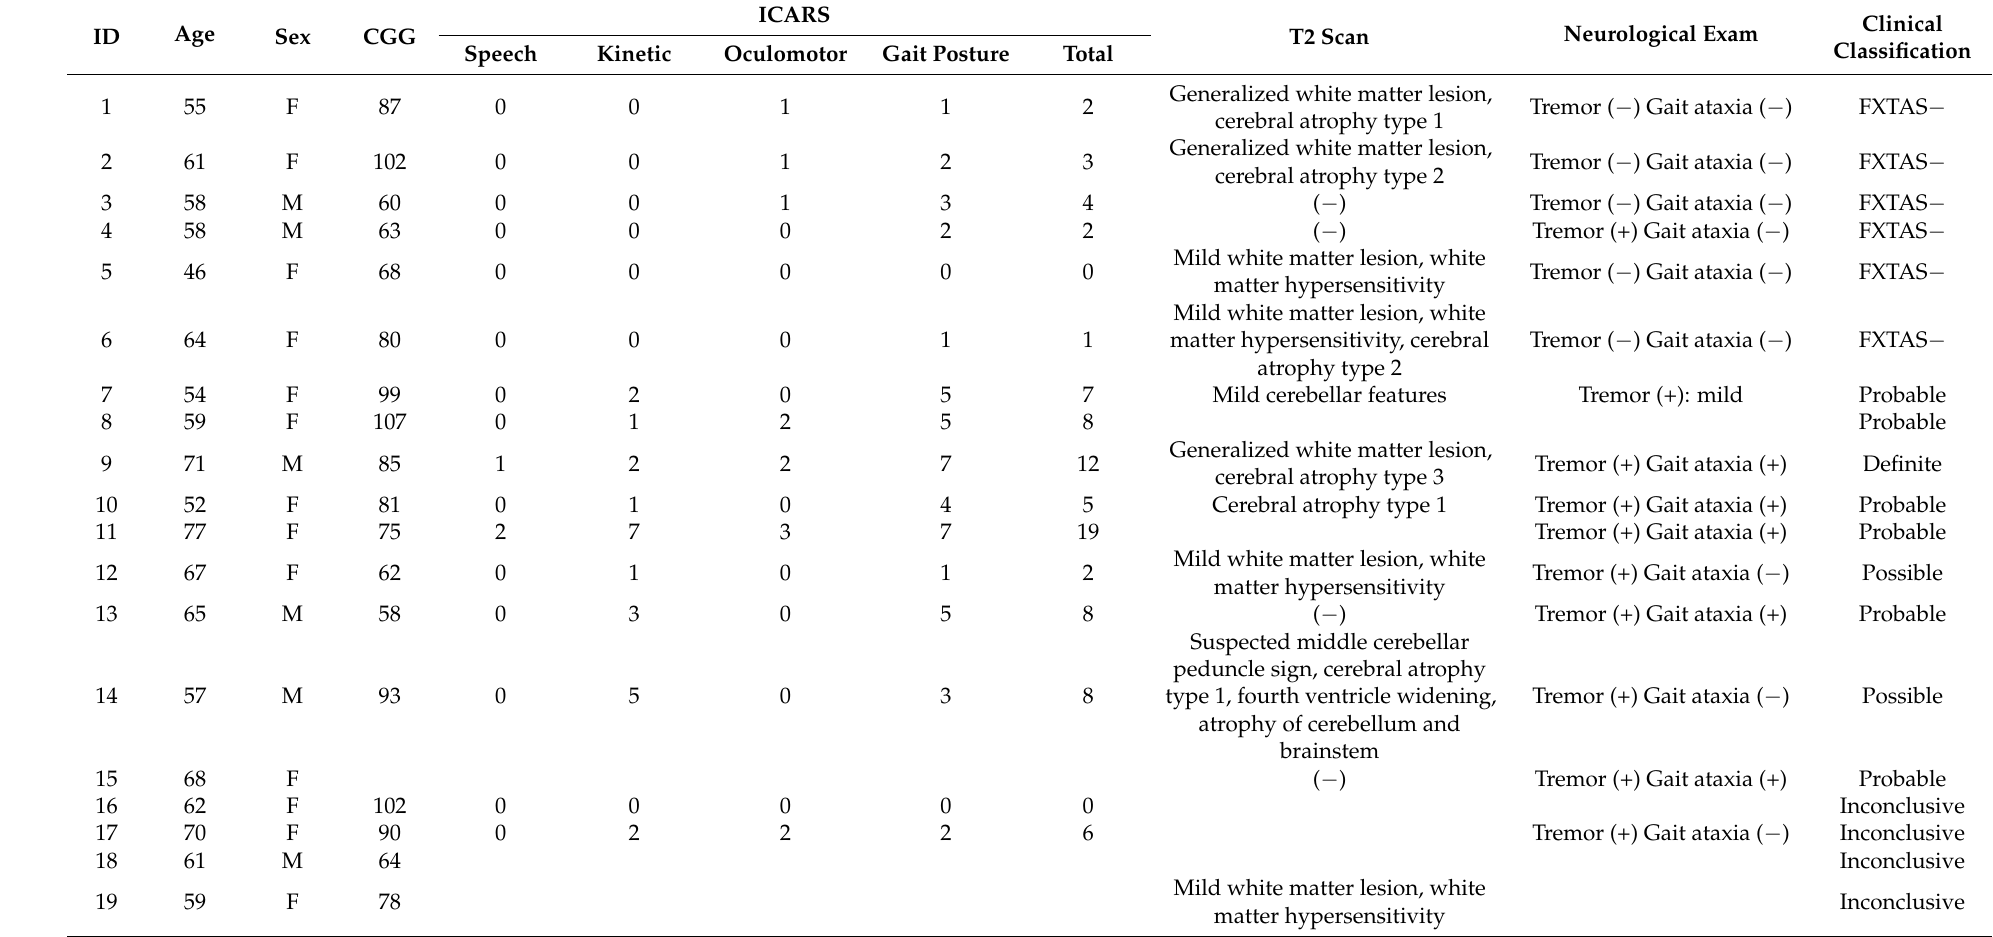
Table 2. Detailed demographic, genetic, and clinical characteristics for each FMR1 gene premutation